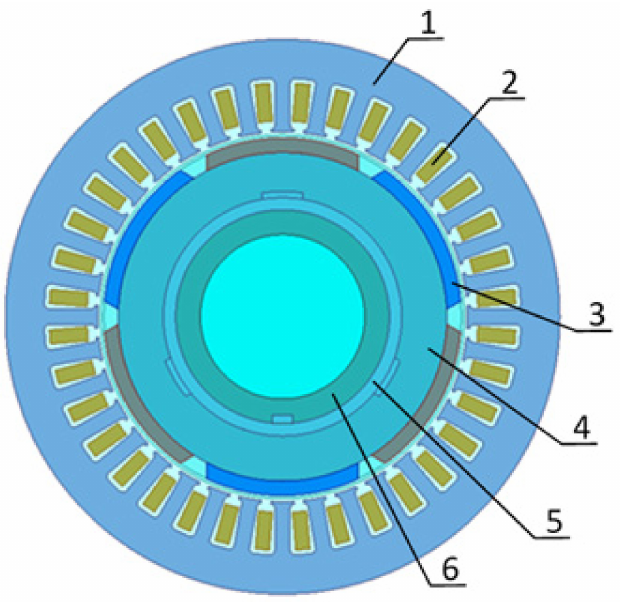
Figure 2. Cross-section of the brushless DC motor. 1—stator core, 2—winding, 3—permanent magnet, 4—rotor yoke, 5—non-magnetic sleeve, 6—pump.